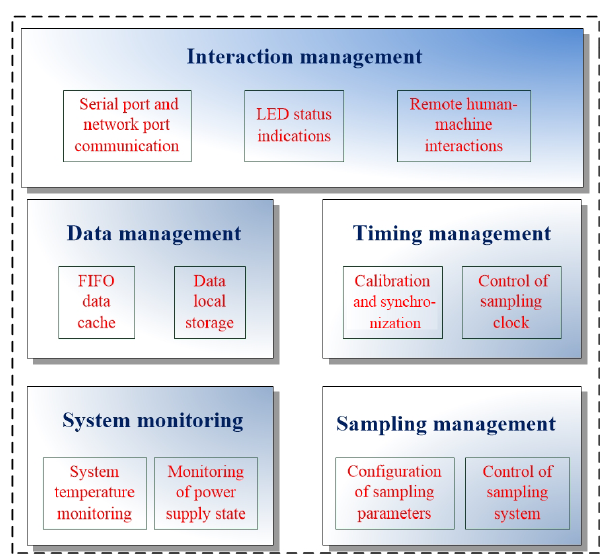
Figure 4. The primary functions of the main control system.